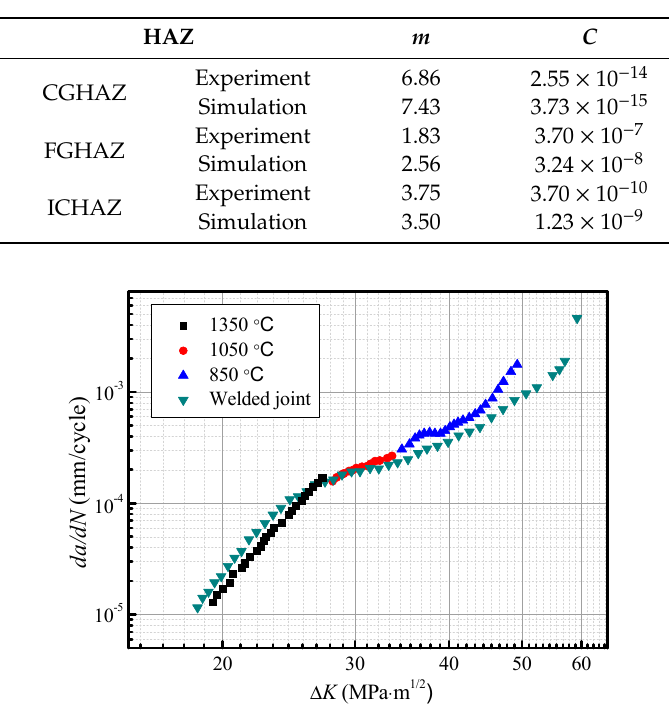
Figure 15. The di ff erence between the actual welded joint specimen and thermal simulation Figure 15. The difference between the actual welded joint specimen and thermal simulation specimen.